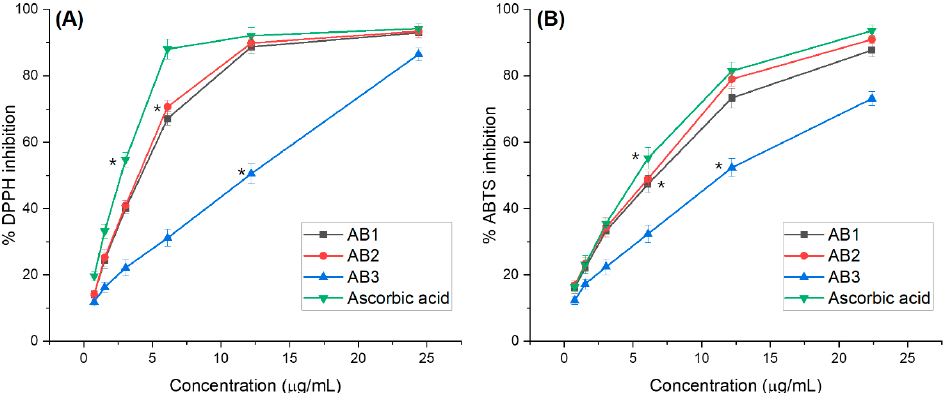
Figure 5. ( A ) 2,2 ‐ diphenyl ‐ 1 ‐ picrylhydrazyl (DPPH) and ( B ) ABTS+ radical scavenging activities.